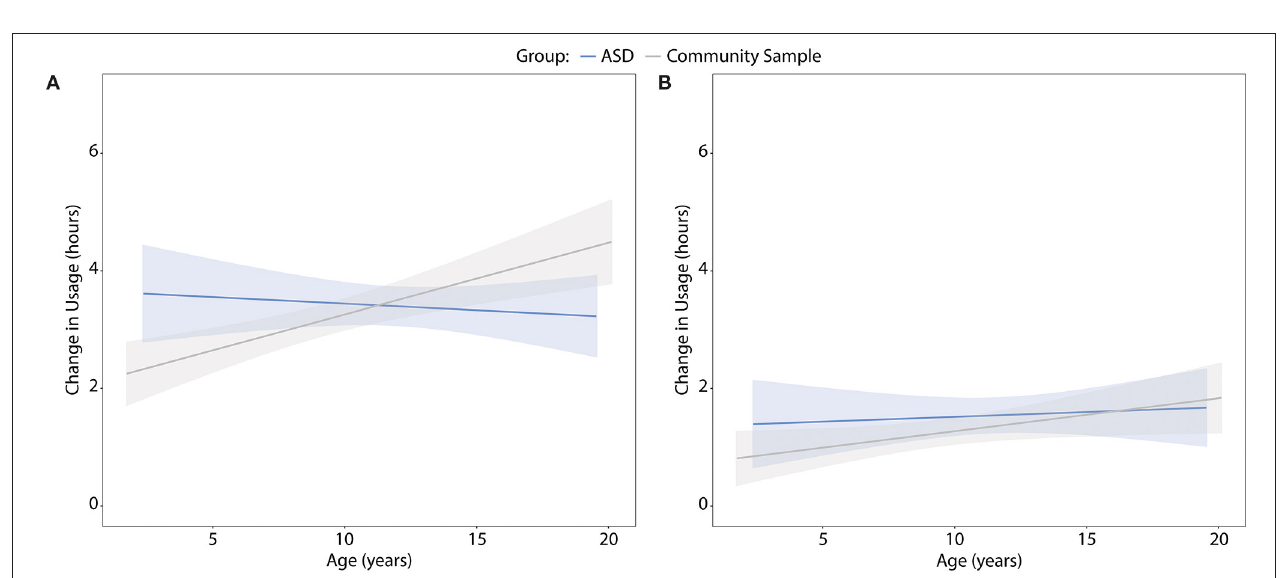
FIGURE 2 | Change in screen time by age during the COVID-19 school closures for children with ASD and the community sample on (A) weekdays and (B) weekends. Colored shading denotes 95% confidence interval.